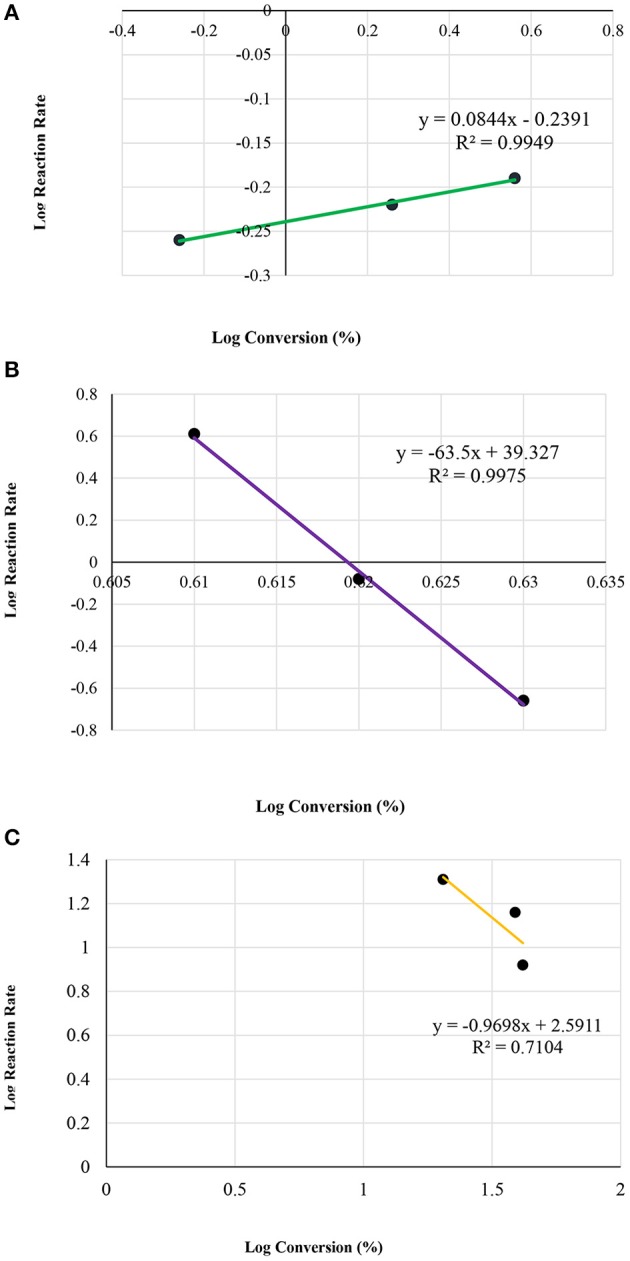
Plot of log initial reaction rate (before 10 min of reaction) vs. log concentrations, of the MCM-41 series; (A) MCM-41(pure); (B) MCM 41-TD, and (C) MCM 41-SU.